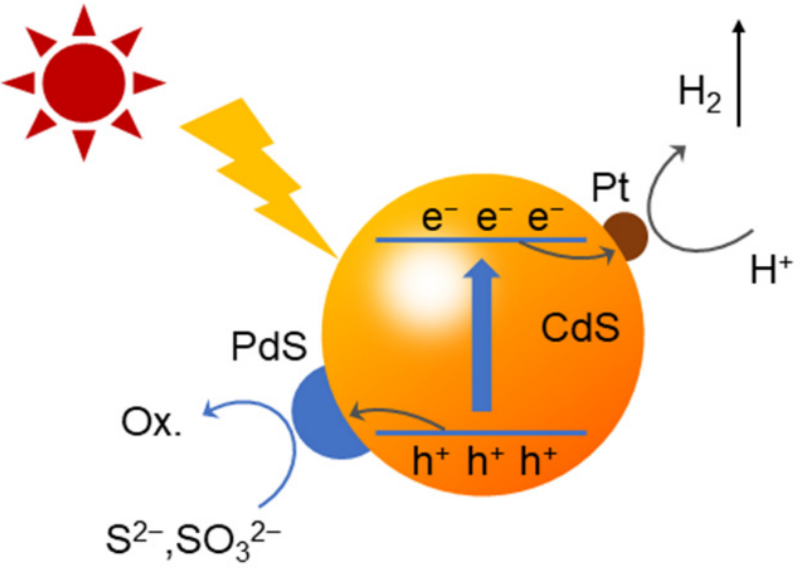
reaction. Table S1: Surface areas and textural properties of CdS(HZ) and CdS(no template); Video S1: Photocatalytic hydrogen evolution over